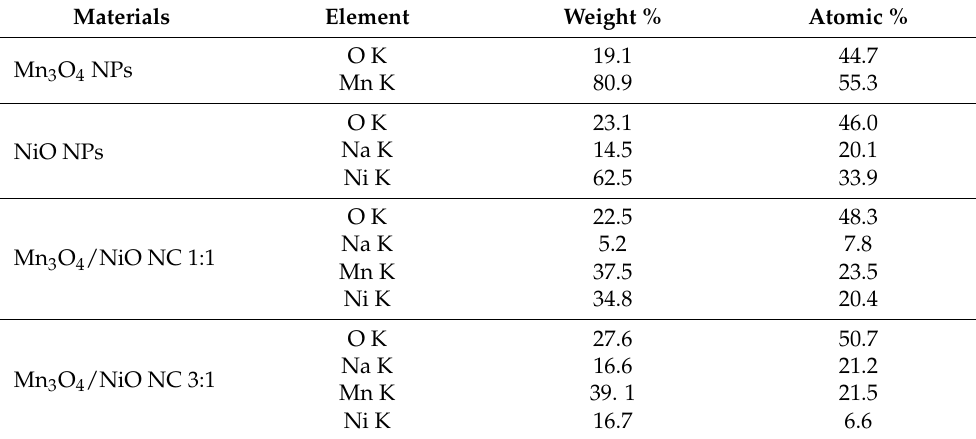
Figure 3. ( a ) EDX image of pure Mn 3 O 4 NPs, ( b ) EDX image of pure NiO NPs, ( c ) EDX image of Mn 3 O 4 /NiO NC (1:1), and ( d ) EDX image of Mn 3 O 4 /NiO NC (3:1). Table 1. Weight and atomic % of the Mn 3 O 4 NPs , the NiO NPs, and the Mn 3 O 4 /NiO (1:1) and (3:1) NCs.